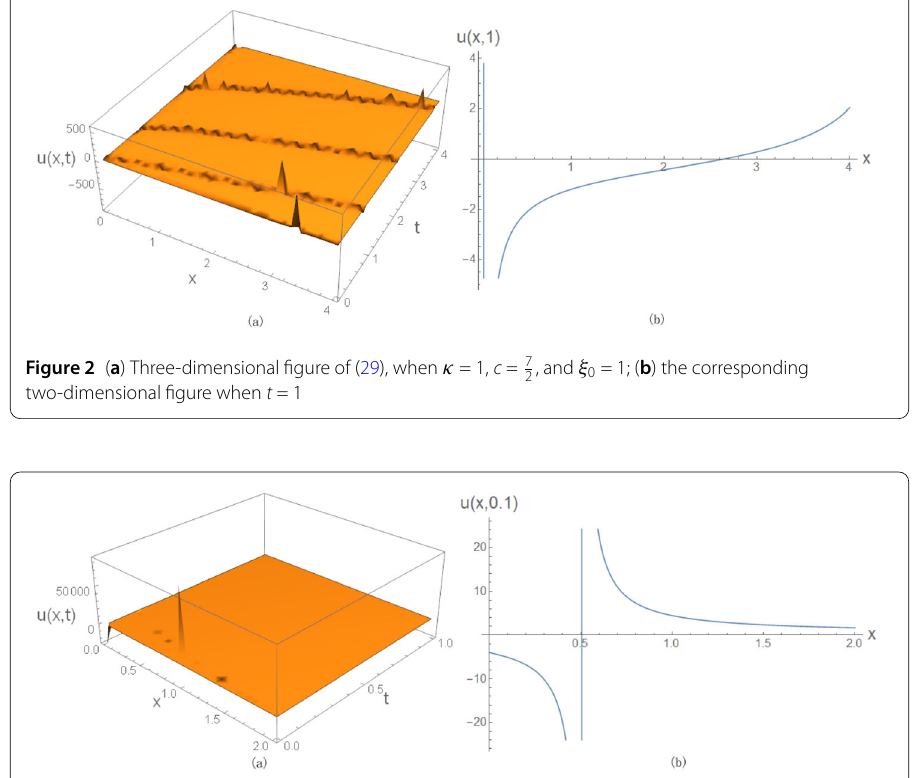
Figure 3 ( a ) Three-dimensional figure of (34), when κ = 1, c = –6, and ξ 0 = 1; ( b ) the corresponding two-dimensional figure when t = 0.1